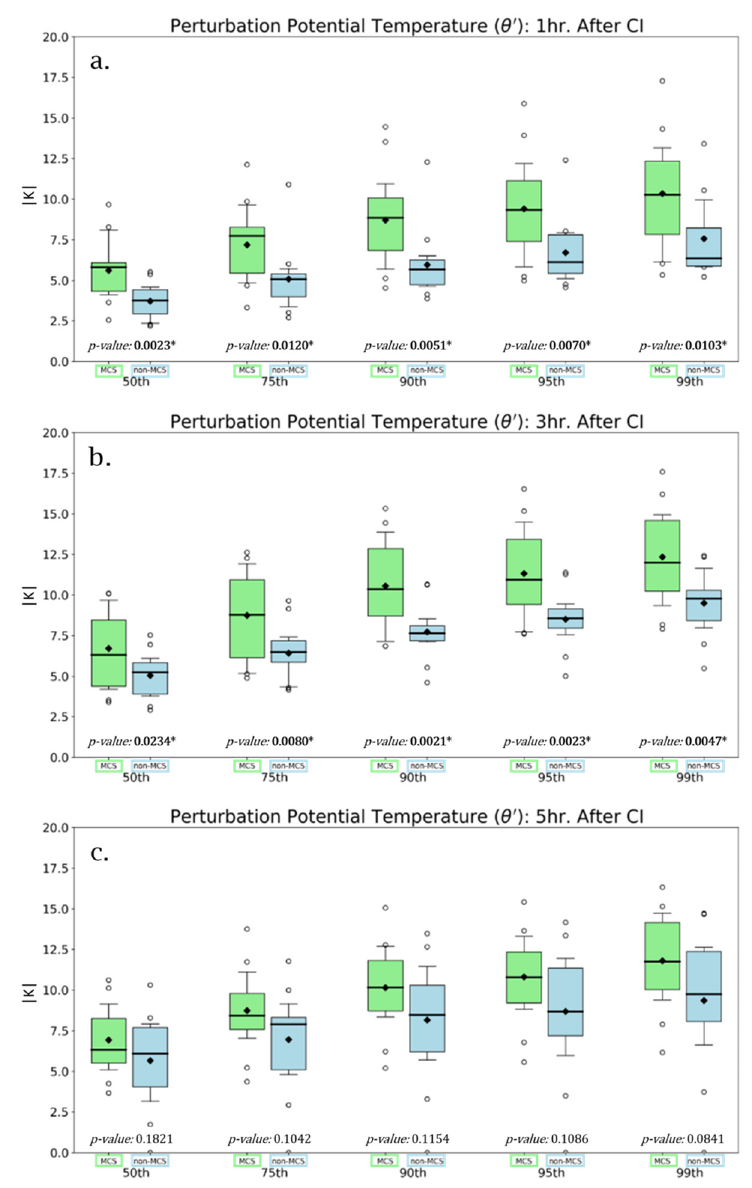
Figure 3. As in Figure 2, but for perturbation potential temperature ( θ ′ in Kelvin) at one, three, and five hours after convective initiation.